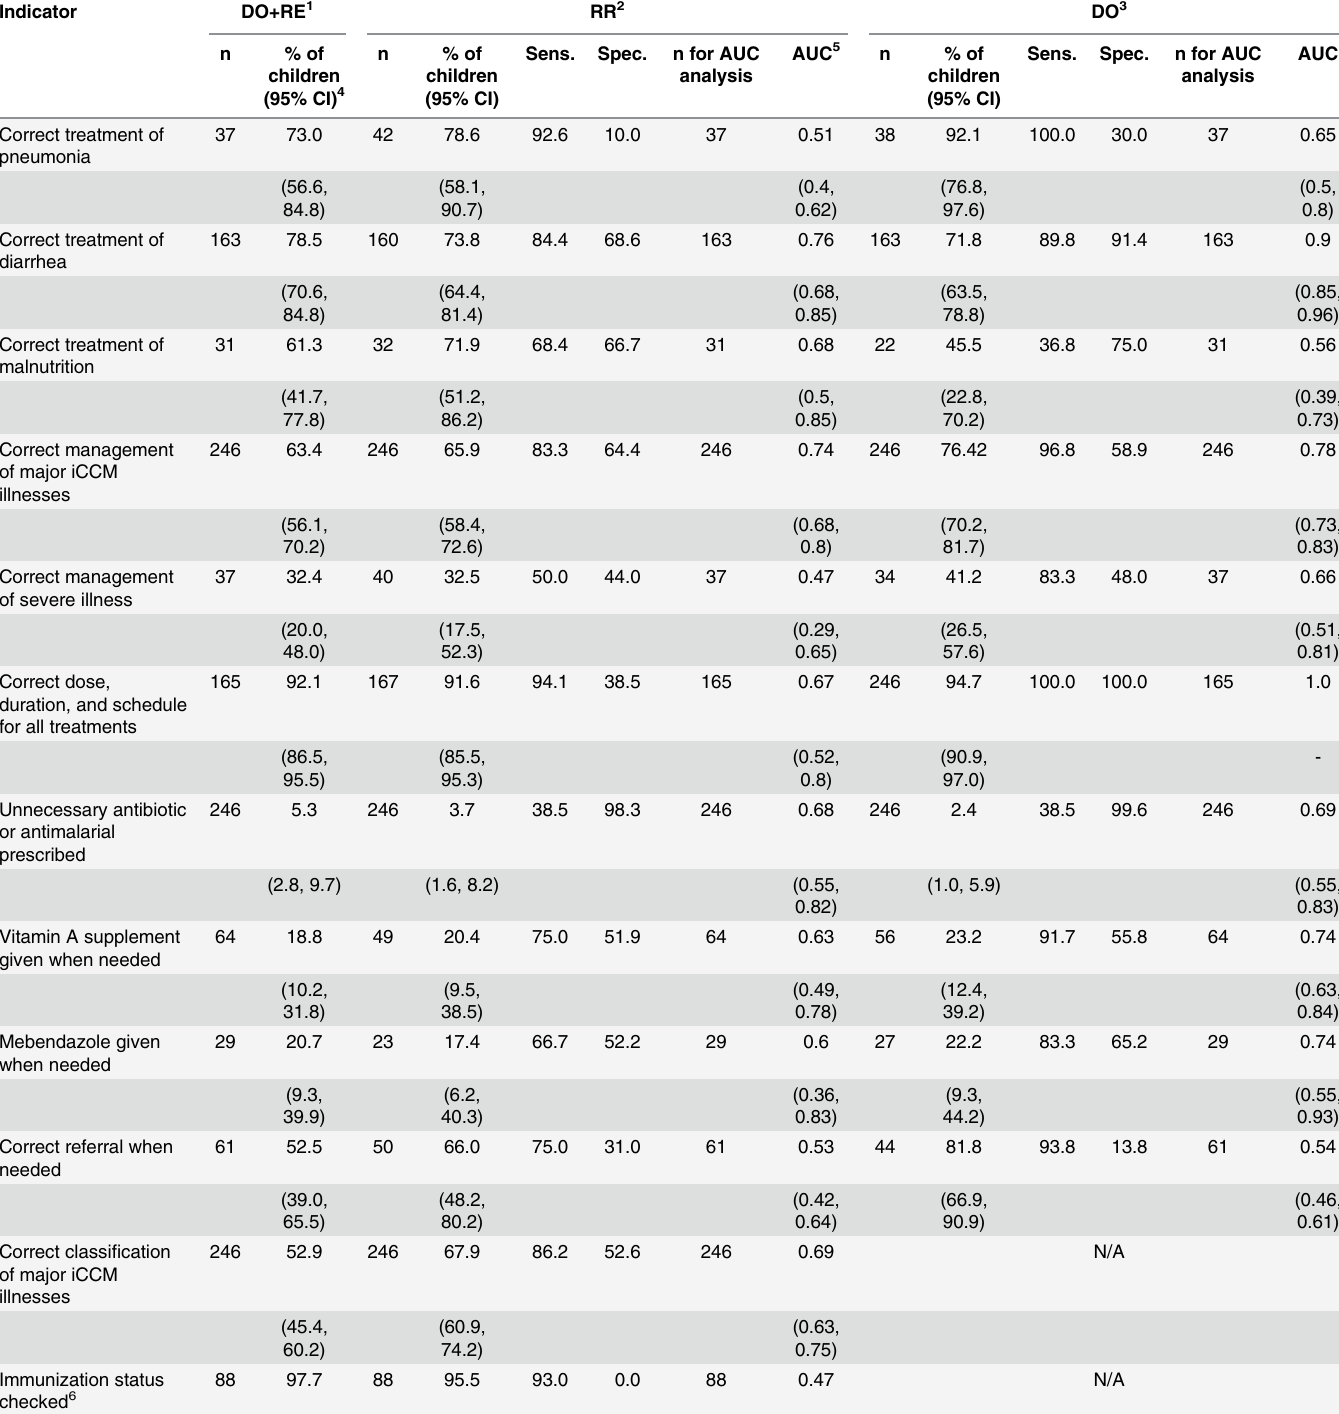
Table 2. Point estimates, sensitivity, specificity, and area under receiver operator characteristic curve for indicators of quality of care from register review and direct observation only compared to direct observation with re-examination.